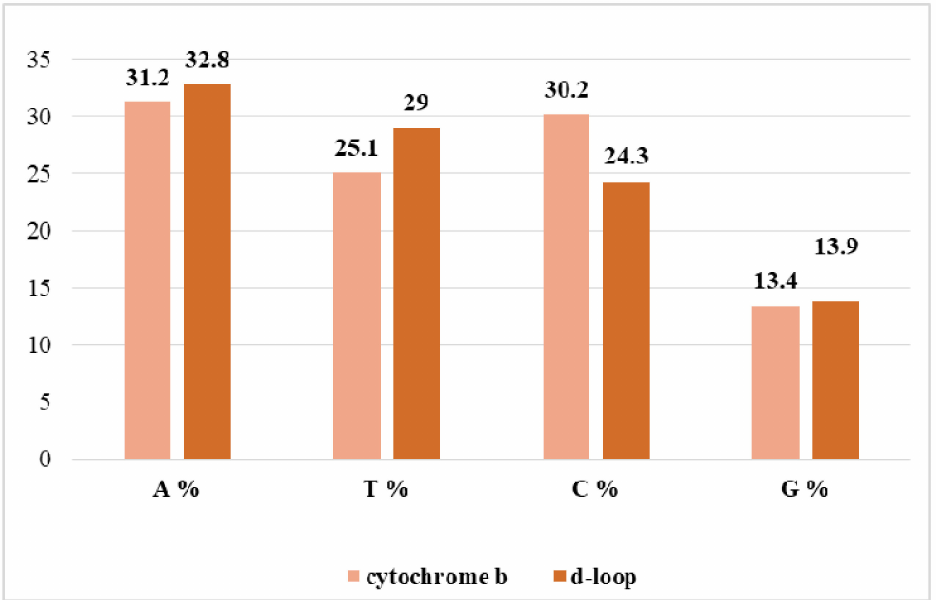
Figure 4. The frequency of nitrogenous bases (A: adenine; T: thymine; C: cytosine; and G: guanine) for the sequences of cytochrome b and